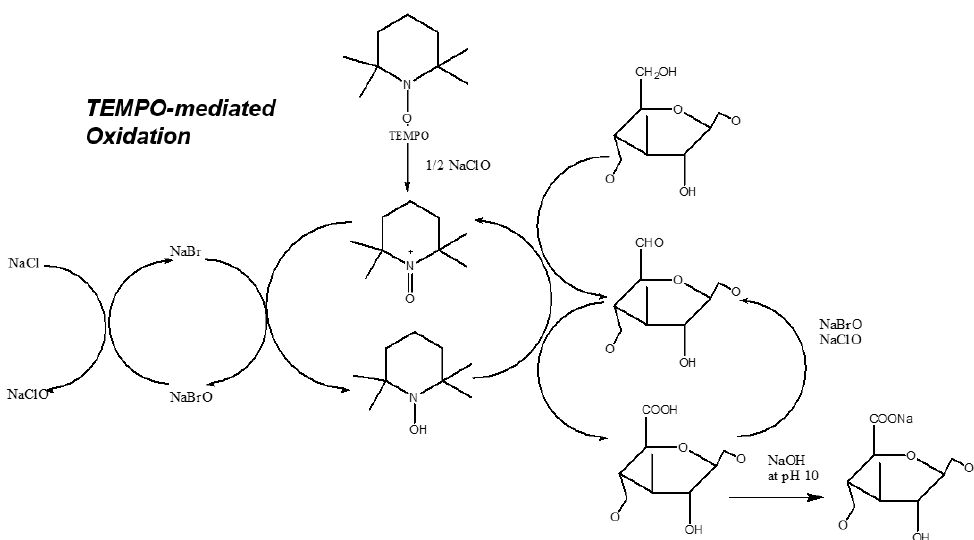
Figure 7. Mechanism of TEMPO-mediated oxidation.